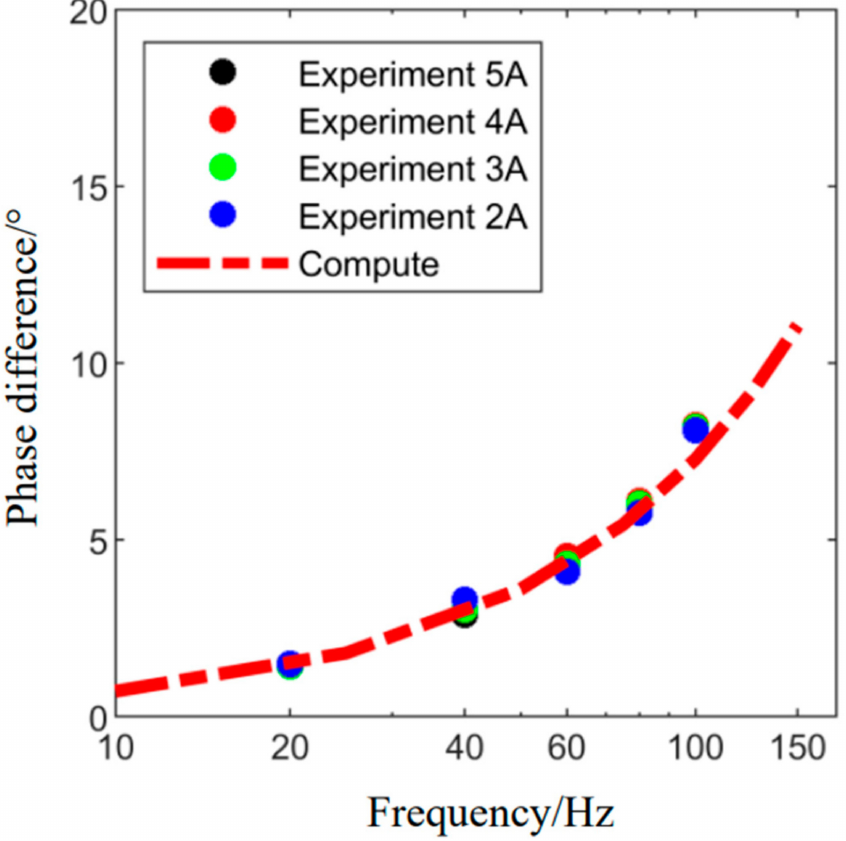
Figure 12. GMA phase-frequency